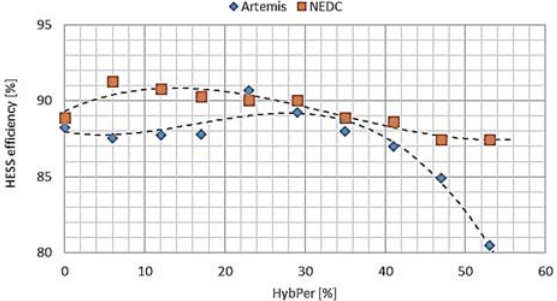
Figure 7. HESS global efficiency for topology 2 as a function of the hybridization percentage for two different driving cycles.